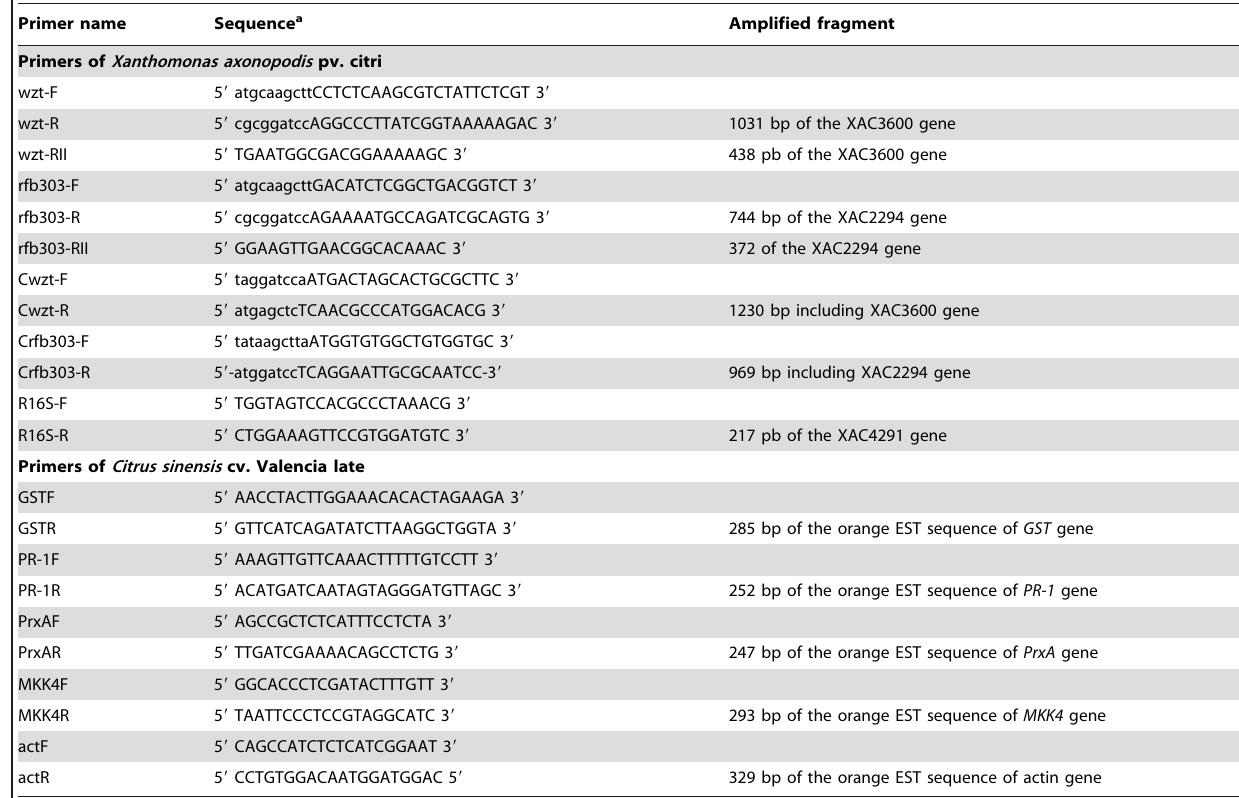
Table 1. Primers used in this